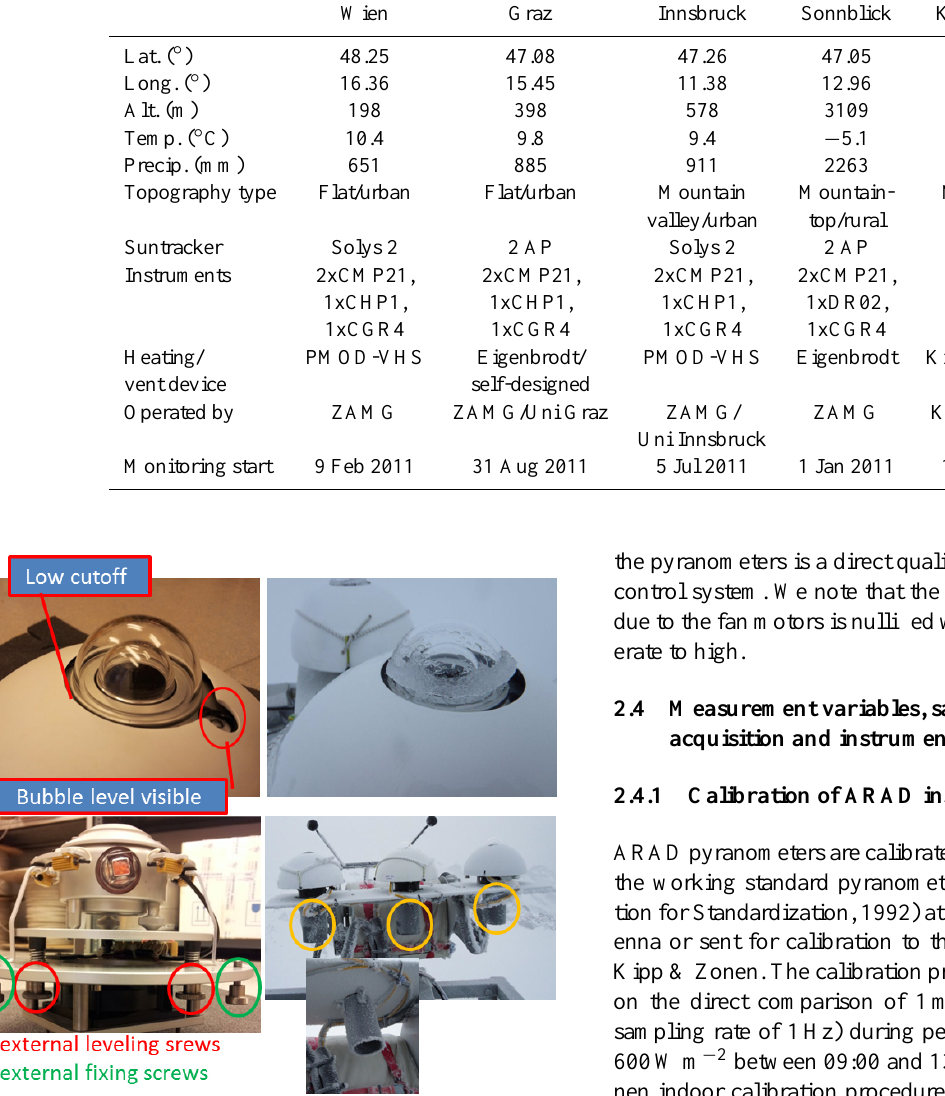
Figure 3. The modified Eigenbrodt heating and ventilation system with external sensor leveling as used for the ARAD stations (left) and some special modification to reduce snow and ice effects at ARAD/BSRN SON station: mounting plastic tubes at the inlet of the heating and ventilation system beneath the instruments (lower right) delay the buildup of rime, leading to reduced ventilation and the buildup of snow/ice on the pyranometer domes, deteriorating the radiation signal (upper